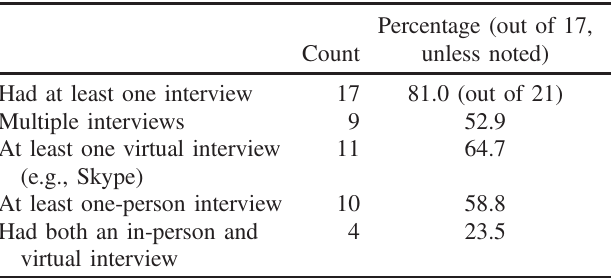
TABLE IV. Summary of postdoc job interviewing.